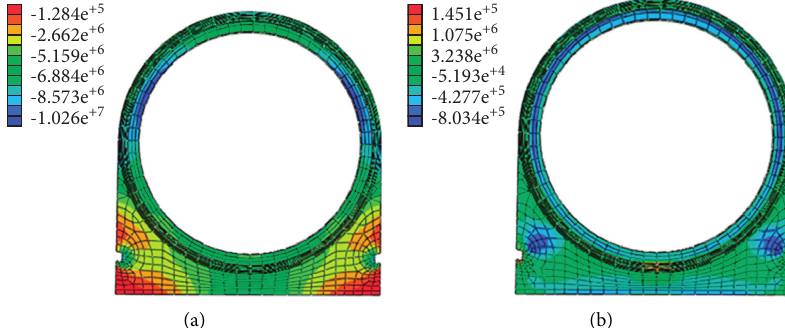
Figure 16: Stress cloud diagram of the prestressed culvert structure: (a) maximum principal stress; (b) minimum principal stress.